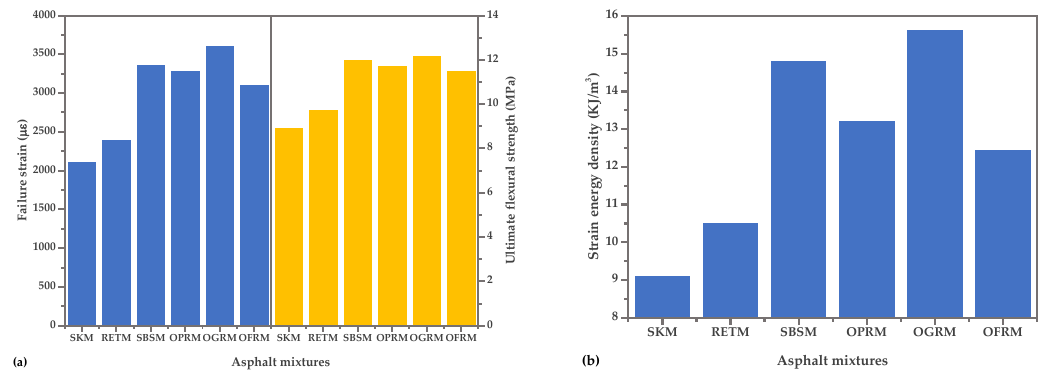
Figure 7. Beam bending test results of mixtures: ( a ) UFS and FS, ( b ) SED.